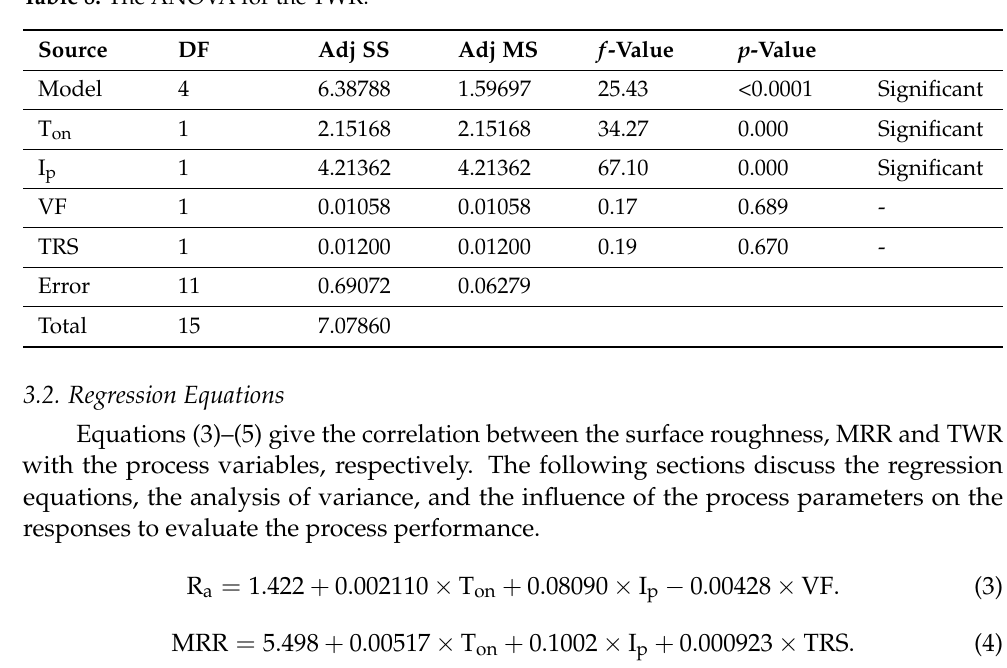
Table 8. The ANOVA for the